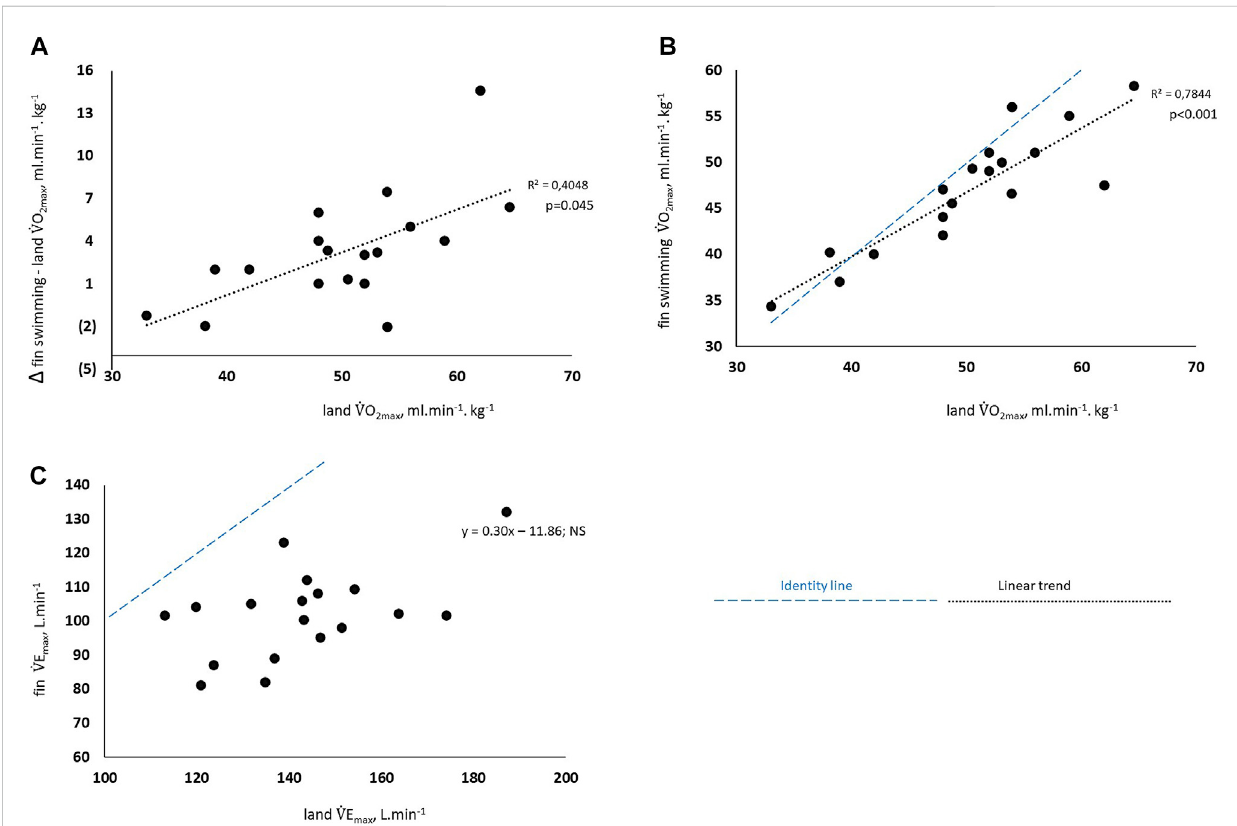
FIGURE 3 Maximum minute ventilation and maximum oxygen uptake in both land cycling and fi n swimming conditions. maximum oxygen uptake ( _ V O 2max ) measured during incremental tests, expressed relative to land _ V O 2max. (cid:129) Oxygen uptake ( _ V O 2max ) in the two conditions. (C) Correlation between the maximum pulmonary ventilation ( _ V E max ) measured in the two conditions. Blue dashed line: identity line; black dashed line: linear trend Statistical signi fi cance was based on a Pearson correlation